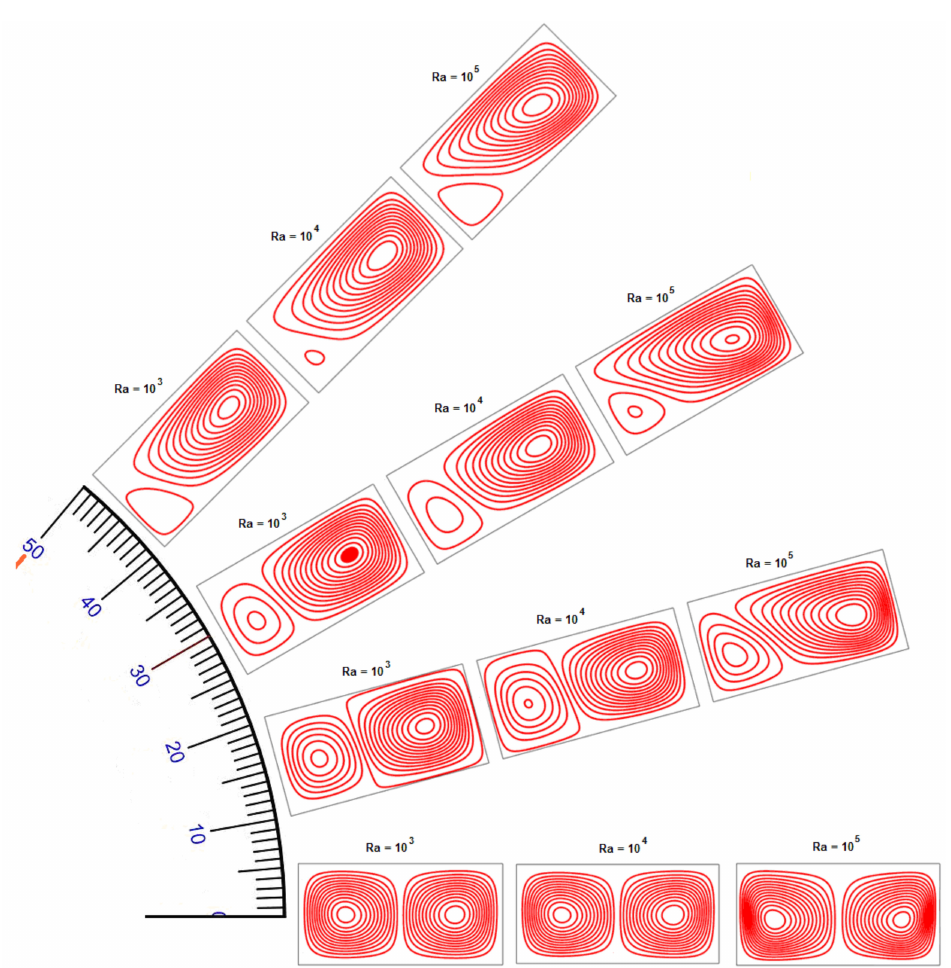
Figure 9. Effects of Rayleigh number and enclosure inclination angle on nanofluid